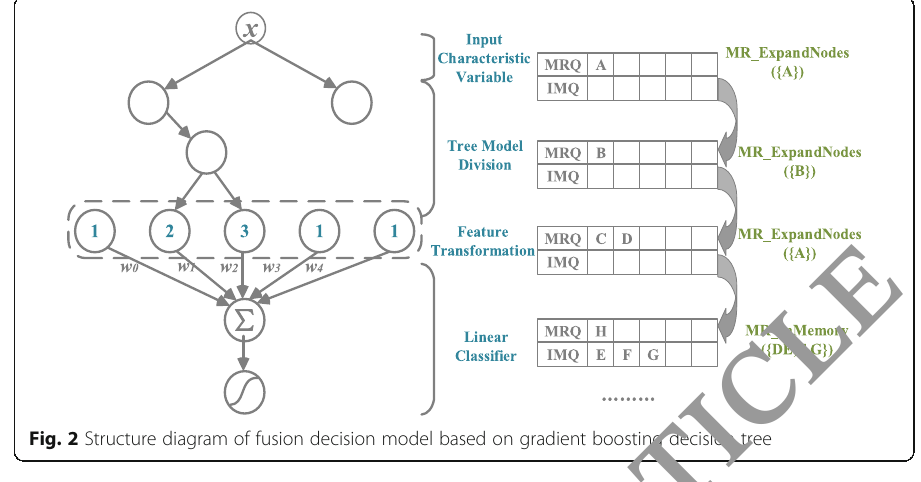
Fig. 2 Structure diagram of fusion decision model based on gradient boosting decision